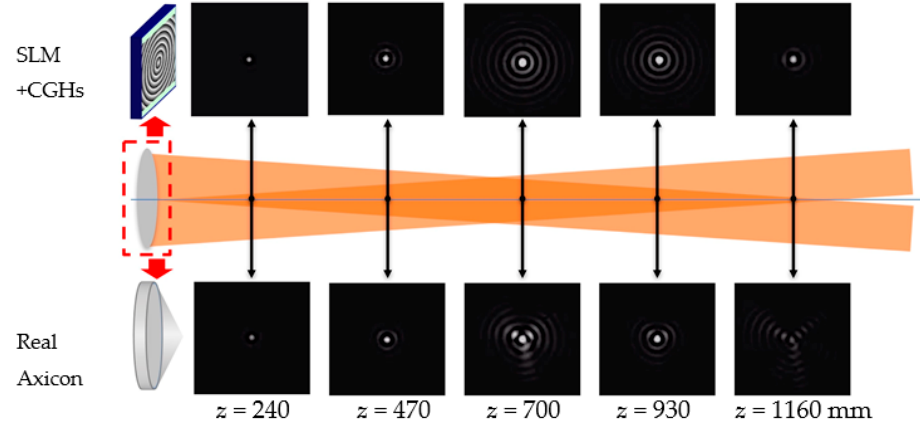
Figure 7. Bessel beams generated by the spatial light modulator (SLM) and the real axicon at different z planes. Table 1. Axial-intensity distributions of Bessel beams of theory generated by the SLM and the real axicon. z Plane (mm)